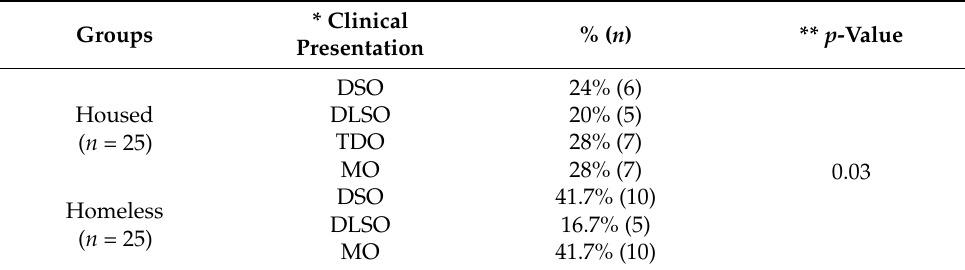
Table 4. Results of relationship between clinical presentation of fungal lesions and study group ( n =